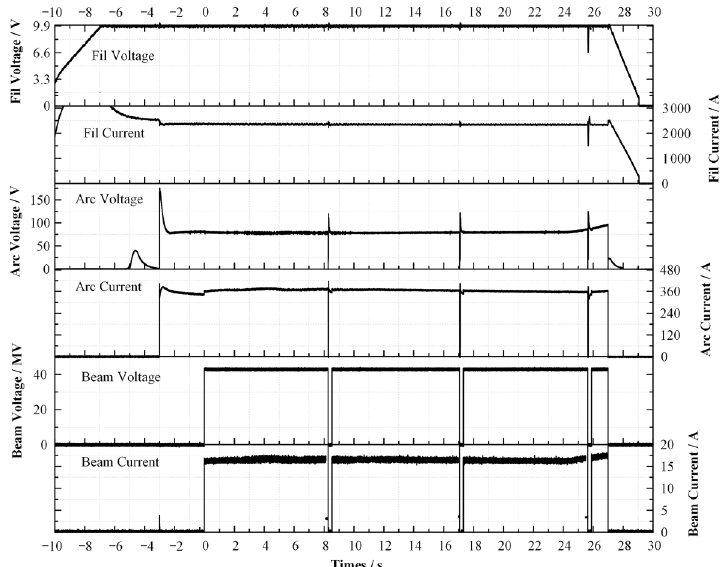
Fig. 5 The typical waveform of long pulse operation with beam re-turn on